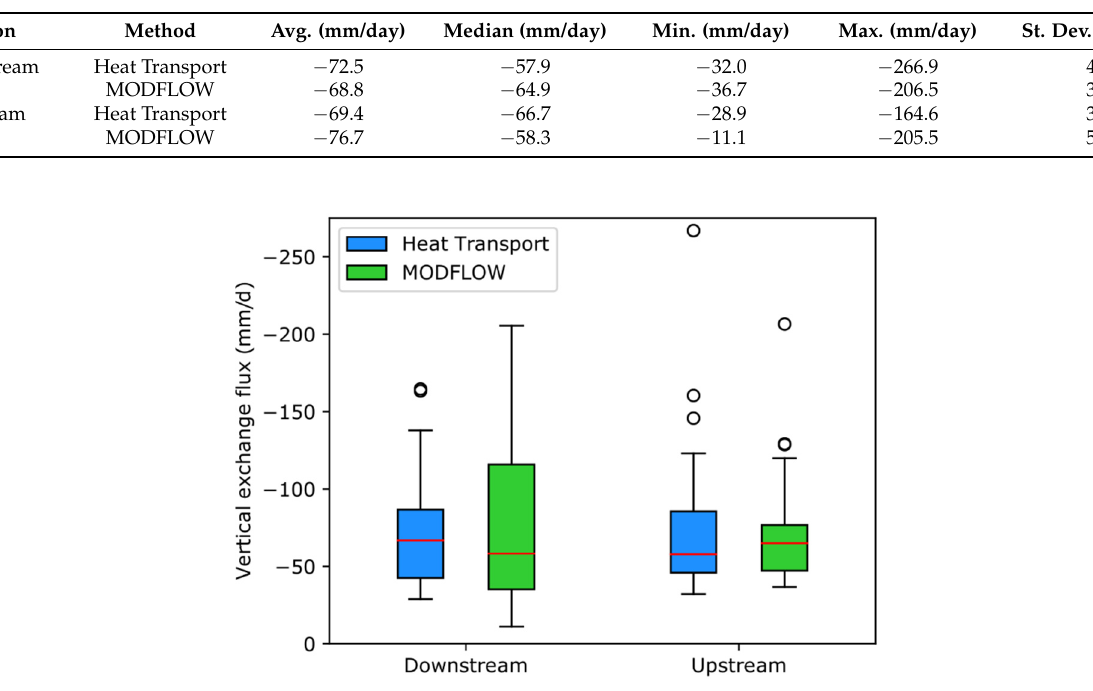
Table 3. Summary statistics of estimated vertical exchange fluxes based on heat transport modelling and groundwater flow modelling at measurement locations of temperature profiles for both the upstream and downstream sections.